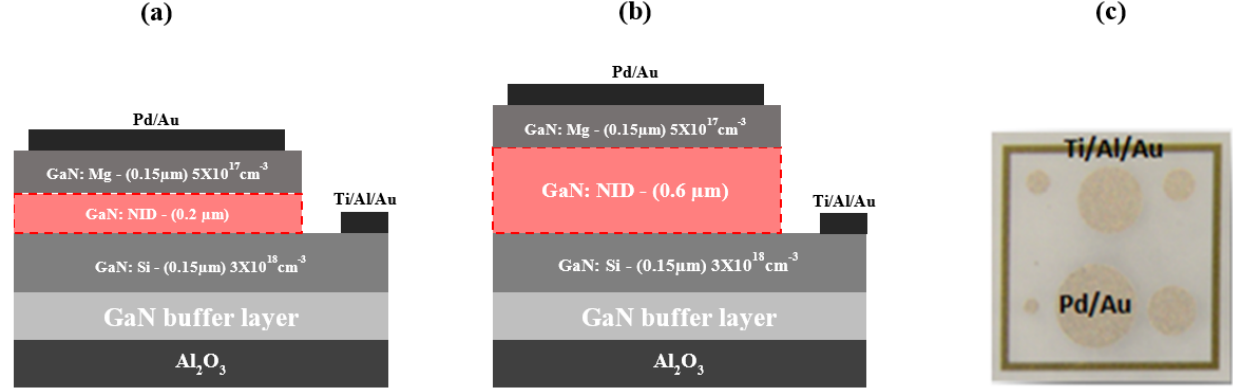
Figure 1. Schematic diagram of the GaN p-i-n junction diode with ( a ) Sample S1 with 0.2 µm undoped GaN layer; ( b ) Sample S2 with 0.6 µm undoped GaN layer; ( c ) Photograph of different-diameter mesa p-i-n diodes after